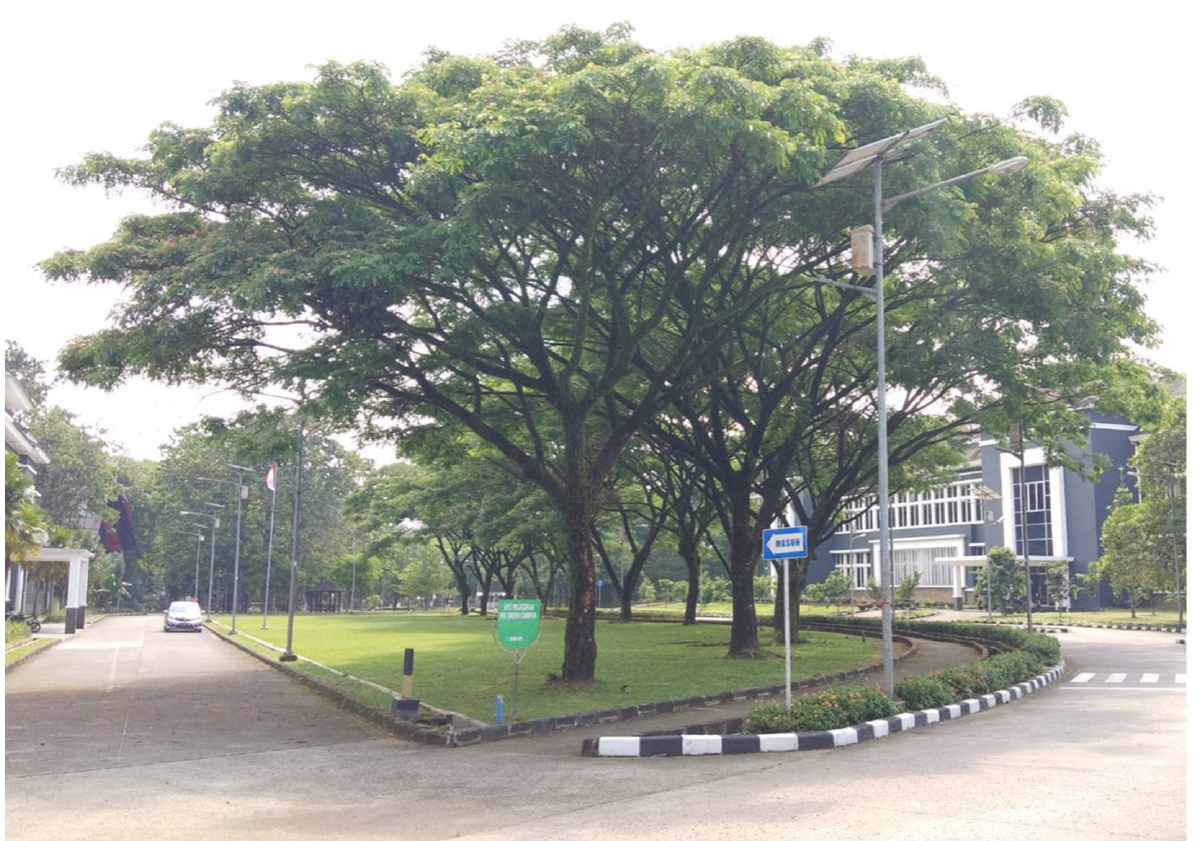
Figure 2. Example of a grove rain trees ( Samanea saman ) in the study location. Dynamic elasticity was determined from sound velocity. Sound velocity was the stress wave velocity ( SWV ) measured in the longitudinal direction on north and west sides of the trunk, using the stress wave timer tool of Fakopp Microsecond Timer (Fakopp Bt, Sopron, Hungary). The measurement was carried out in an area of the tree stem without visible defects, and sensors were placed into the wood, penetrating the bark. The height of the first sensor of the tool, the receiver, was mounted to the stem at 60 cm above the ground and another sensor, the transmitter, was mounted 100 cm above the receiver [19]. Sound was generated by hitting the transmitter sensor with a hammer (Figure 3). The sound propagation time was recorded in a reading device, and the sound velocity was calculated as the ratio of the space between the two sensors divided by the propagation time. SWV on standing trees can be used to determine the dynamic modulus of elasticity ( Ed ) of the wood, which has a satisfactory correlation with timber quality [19,29–31]. The Ed was determined as follows: æ Ed ( GPa ) = SWV 2 g where Ed is in GPa, SWV in m · s − 1 , ρ is wood density (g · cm − 3 ), and g is a gravitational constant (9.81 m · s − 2 ). Wood density and moisture content were determined based on the ratio of mass to volume and a gravimetry method, respectively, from a small core sample obtained about 5 cm deep from the bark with a diameter of about 1 cm and a length of 2 cm that was extracted from each study tree using an increment core